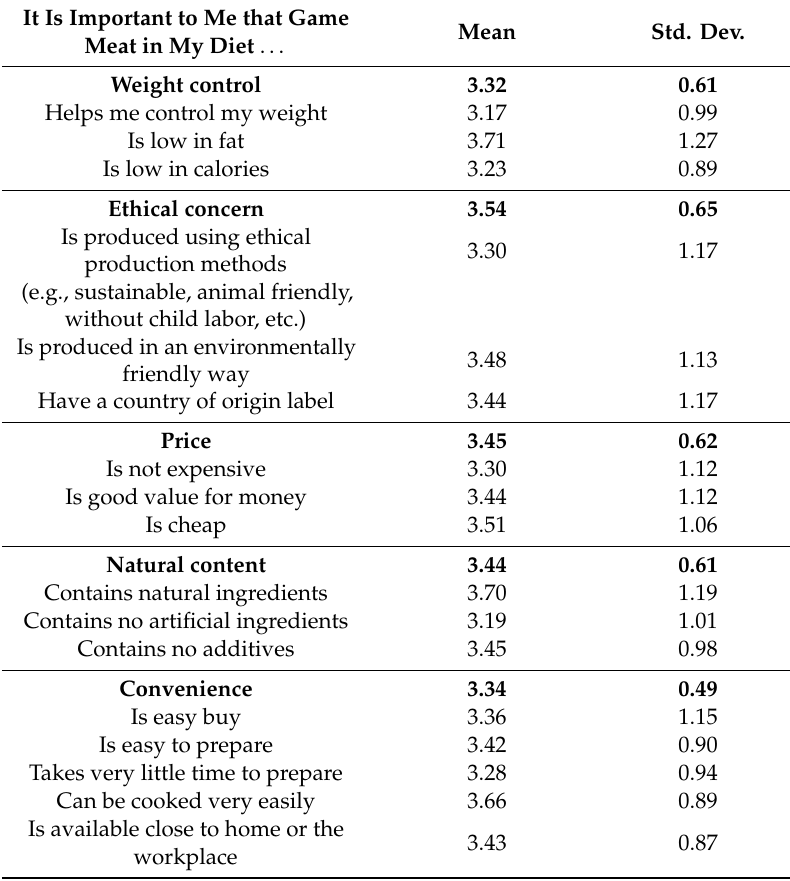
Table 2. Emotional motives for game